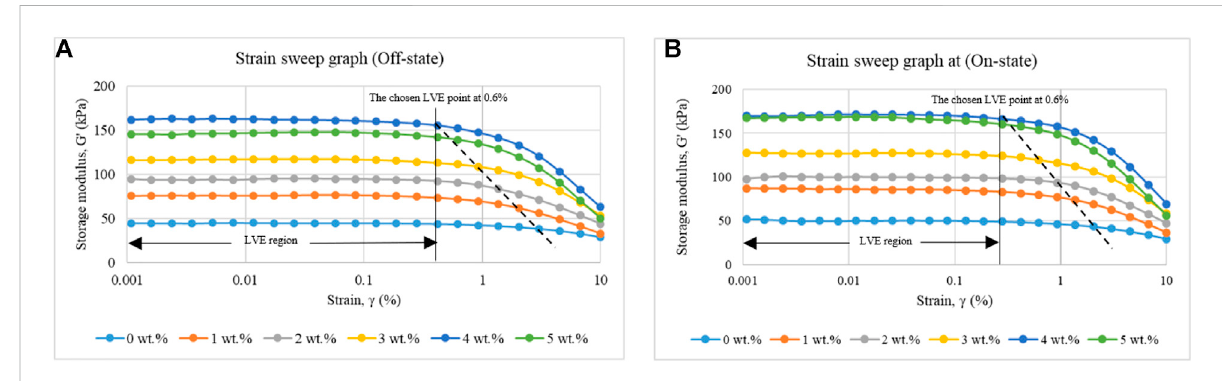
FIGURE 2 Change of storage modulus of MR foams with different concentrations of silica nanoparticles during (A) off-state (0 T) and (B) on-state (0.73 T) conditions.